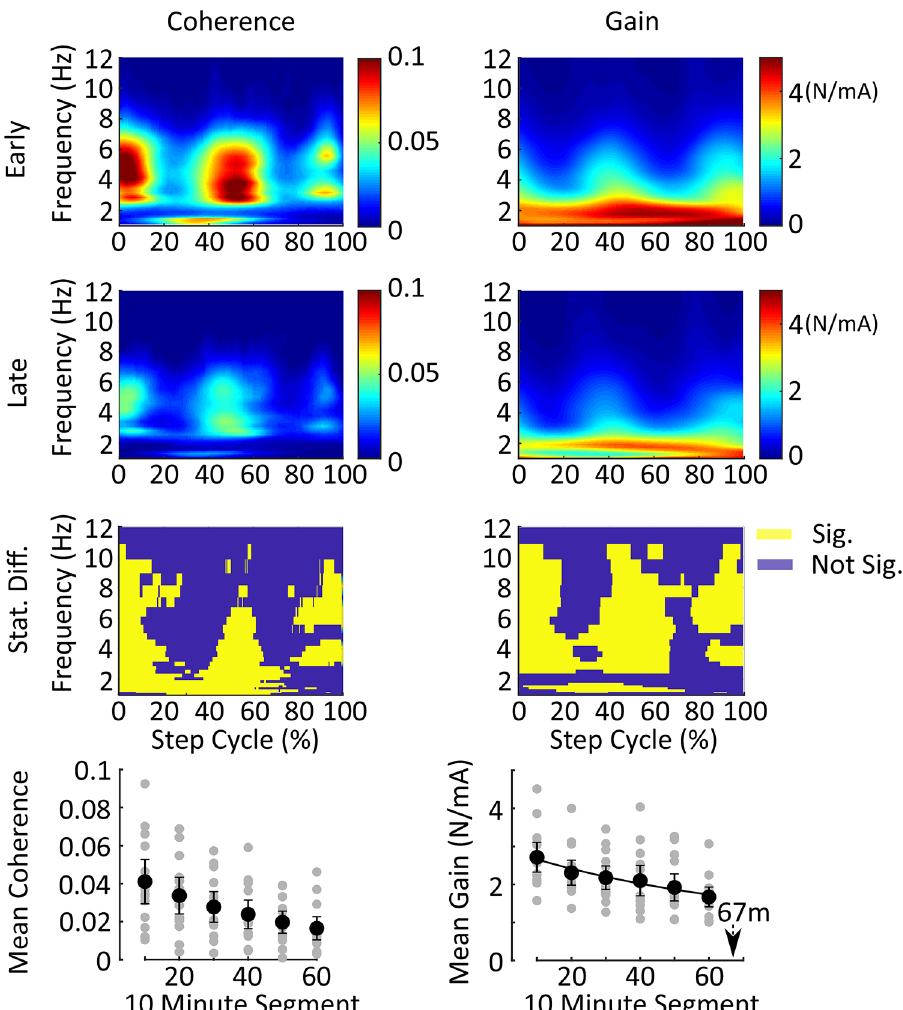
Figure 5. Time–frequency representation of the change in stimulus-medio-lateral force coherence and gain during each stride of the Walking Treatment condition. The top three rows illustrate changes in walking- coherence (first column) and walking-gain (second column) for the first (early) and last (late) 10-min walking periods. Prolonged periods of stimulation during walking resulted in a significant decrease in walking-coherence and walking-gain (row 3). The difference in coherence and gain plots were calculated by bootstrapping the difference-of-means distribution over time and frequency, and the 95% confidence interval was estimated using the percentile method. Regions in the early and late panels where the confidence intervals of the difference-of-means distribution excluded zero (yellow regions) were deemed significantly different from each other. The fourth row illustrates the mean walking-coherence (over time and frequency) for regions of significant coherence in each of the six 10-min periods. Walking-coherence and walking-gain decreased over the duration of the 60-min period. Error bars are the 95% confidence intervals of the mean. The decrease in mean walking-gain was fit with a decaying exponential (black line) and the arrow indicates the exponential’s time constant, which was 67 min. Mean coherence and gain were calculated only for times and frequencies in which coherence was significantly different from zero in the first 10-min time-period using a 95% confidence limit based on the number of strides contributing to the coherence estimate. m